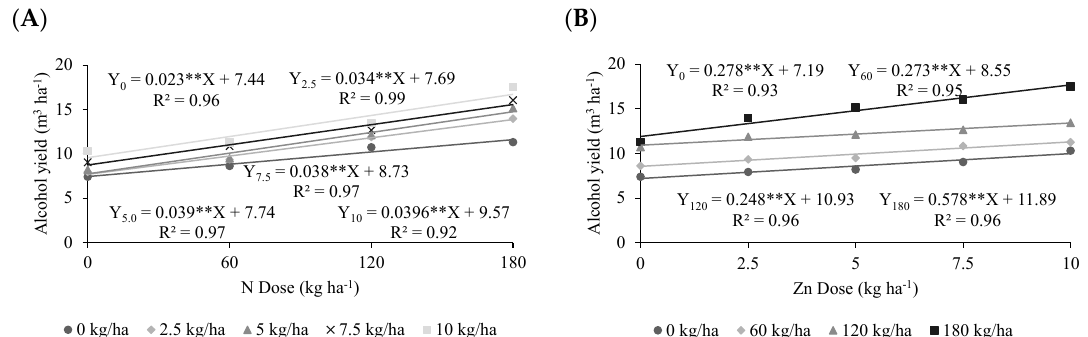
Figure 6. Alcohol yield of sugarcane (plant crops) in response to nitrogen ( A ) and zinc ( B ) fertigation doses, under field conditions in Jataí, GO, Brazil. ** significant at p < 0,01 probability according to the F test. Doses of Zn, Y 0 : 0 kg ha − 1 of Zn, Y 2.5 : 2.5 kg ha − 1 of Zn, Y 5.0 : 5.0 kg ha − 1 of Zn, Y 7.5 : 7.5 kg ha − 1 of Zn and Y 10 : 10 kg ha − 1 of Zn ( A ). Doses of N, Y 0 : 0 kg ha − 1 of N, Y 60 : 60 kg ha − 1 of N, Y 120 : 120 kg ha − 1 of N, Y 180 : 180 kg ha − 1 of N ( B ).